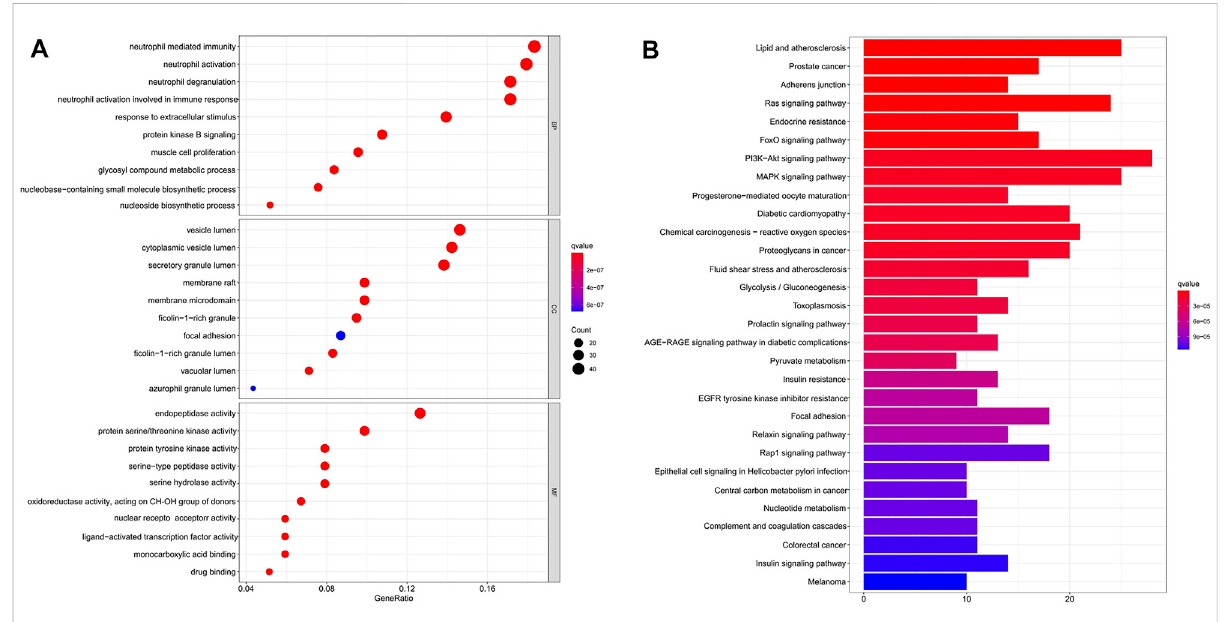
FIGURE 4 GO and KEGG pathway enrichment analysis. (A) GO analysis enrichment of candidate target genes of scutellarin for AML treatment. (B) KEGG pathways enrichment of candidate target genes of scutellarin against AML. ( p <